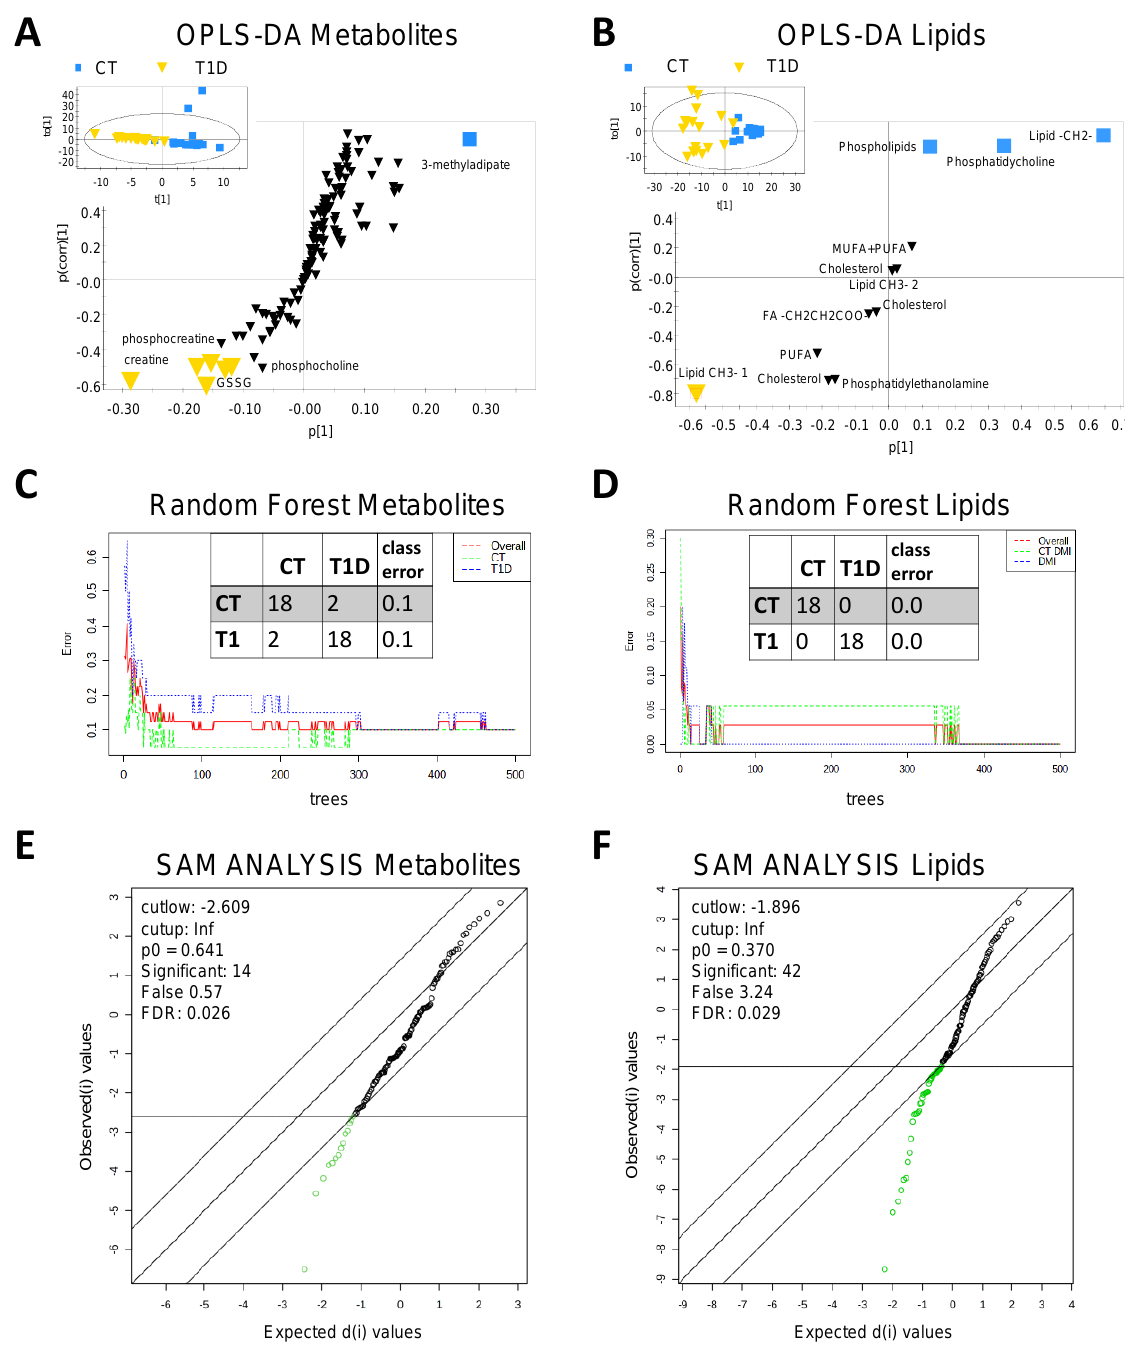
Figure 1. ( A ) Score and S-plot from OPLS-DA analysis comparison of the aqueous RBC profile of T1DM patients and healthy controls. RY(cum) = 0.77, Q(cum) = 0.64, CV-ANOVA = 3.9 × 10 −6 . ( B ) Score and S-plot from OPLS-DA analysis comparison of the lipidomic RBC profile of T1DM patients and healthy controls. RY(cum) = 0.83, Q(cum) = 0.66, CV-ANOVA = 1.1× 10 −6 . ( C ) Random Forest classification of aqueous RBC metabolites of T1D patients and healthy controls, 500 trees, 7 predictors, randomness. ( D ) Random Forest classification of lipidic RBC metabolites of T1D patients and healthy controls, 500 trees, 5 predictors, fixed seed. ( E ) SAM analysis of aqueous metabolites, Delta = 1.4, FDR 0.026, significant compounds: 14. ( F ) SAM analysis of lipidic metabolites, Delta = 0.1, FDR 0.025, significant compounds: